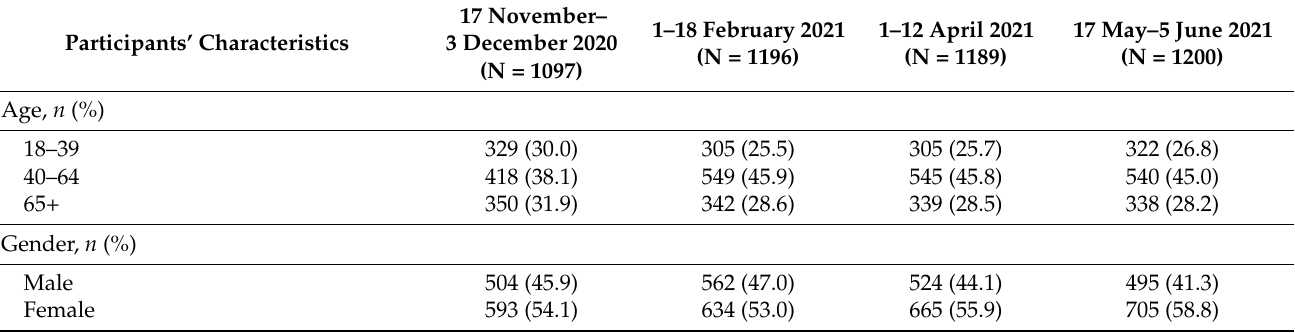
Table 1. Socio-demographic characteristics of the participants in the 4 phone surveys in